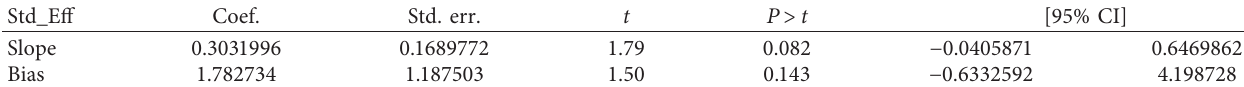
Table 5: Egger’s test results presenting publication bias in the